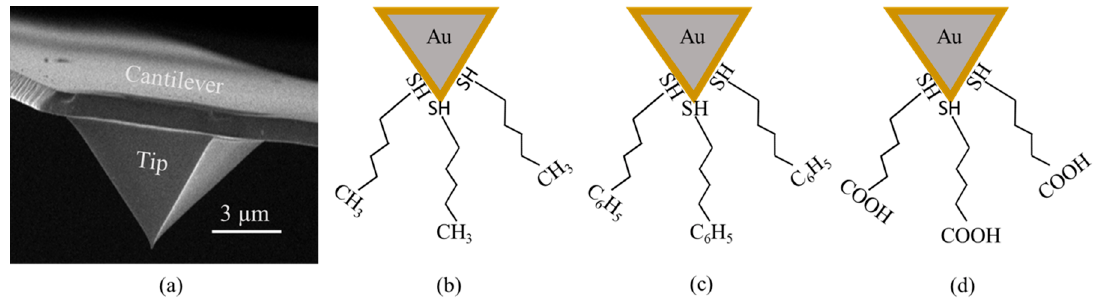
Figure 2. Scanning Electron Microscope (SEM) micrograph of an AFM probe and conceptual schematic of functionalized tips. ( a ) A Pyrex PNP-TR-Au probe with gold coated cantilever and tip; the functionalization procedure is completed with the tip-thiol bond on one end, a long hydrocarbon chain, and ( b ) -CH 3 , ( c ) -C 6 H 5 and ( d ) -COOH groups on the extreme end which contacts the mineral substrates. Table 3. Thiol solutions used to functionalize AFM probes, and key